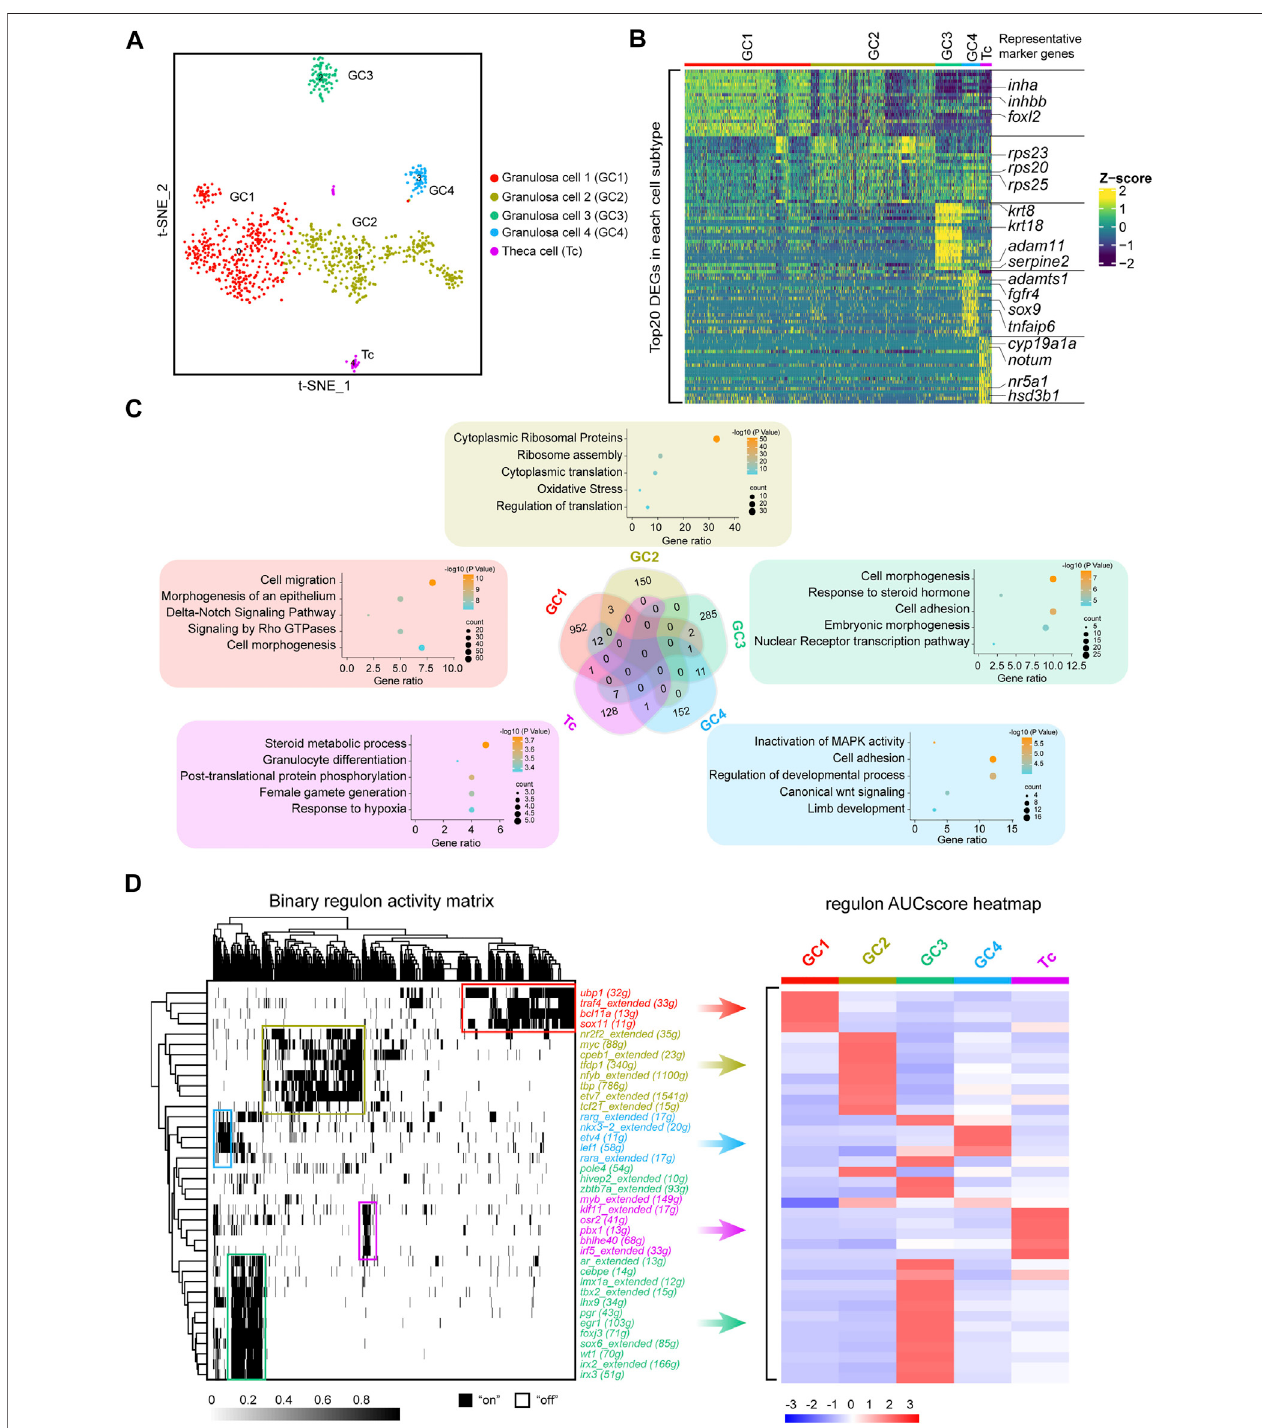
FIGURE 3 | Identi fi cation of fi ve discrete transcriptional states of follicle cells. (A) UMAP of follicle cell re-clustering. (B) Heatmap of the top 20 DEGs in different subclustersoffolliclecells.Thecoloursfromdarkbluetoyellowindicatelowtohighgeneexpressionlevels,respectively.Representativemarkergenesareshowninright. (C) Venn diagram showing the intersection of DEGs of the fi ve subclusters. Representative enriched terms for DEGs are shown. (D) Left: SCENIC binary regulon activity heatmap depicting follicle cell-enriched regulons. “ On ” indicates active, while “ Off ” indicates inactive; Right: Heatmap of the AUC scores of follicle cell subtype- speci fi c regulons. The regulons correspond to the graph on the left.